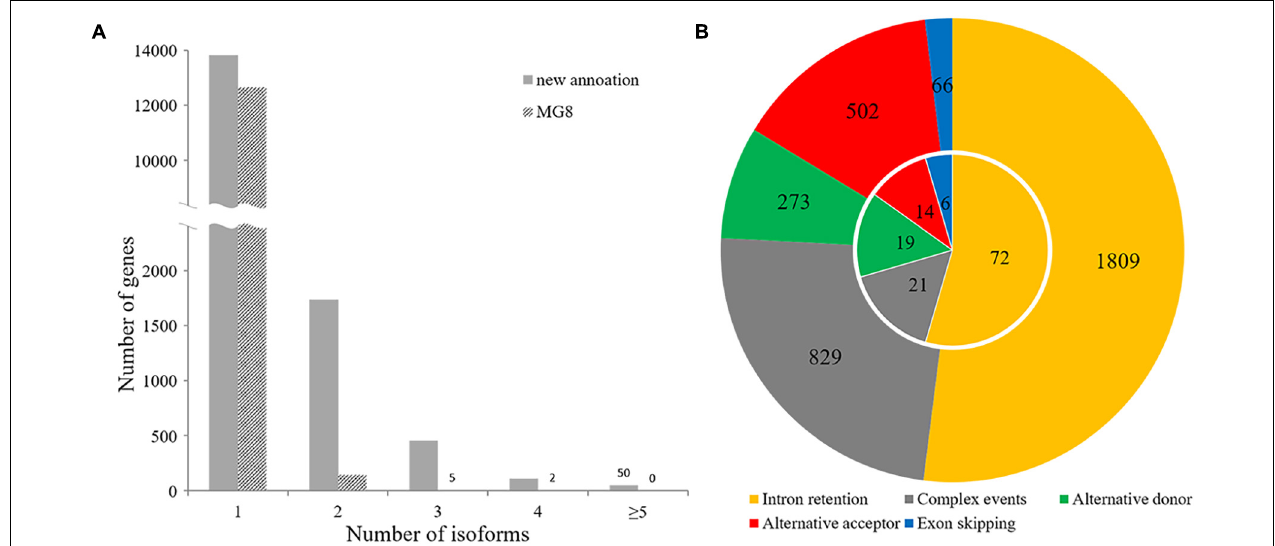
FIGURE 6 | Alternative splicing analysis. (A) Distribution of the number of transcript isoforms per gene in the incumbent annotation and MG8 annotation. (B) Circle plot of patterns of alternative splicing events. The inner and outer circles indicate alternative splicing events observed in the MG8 annotation (strain 70-15) and this